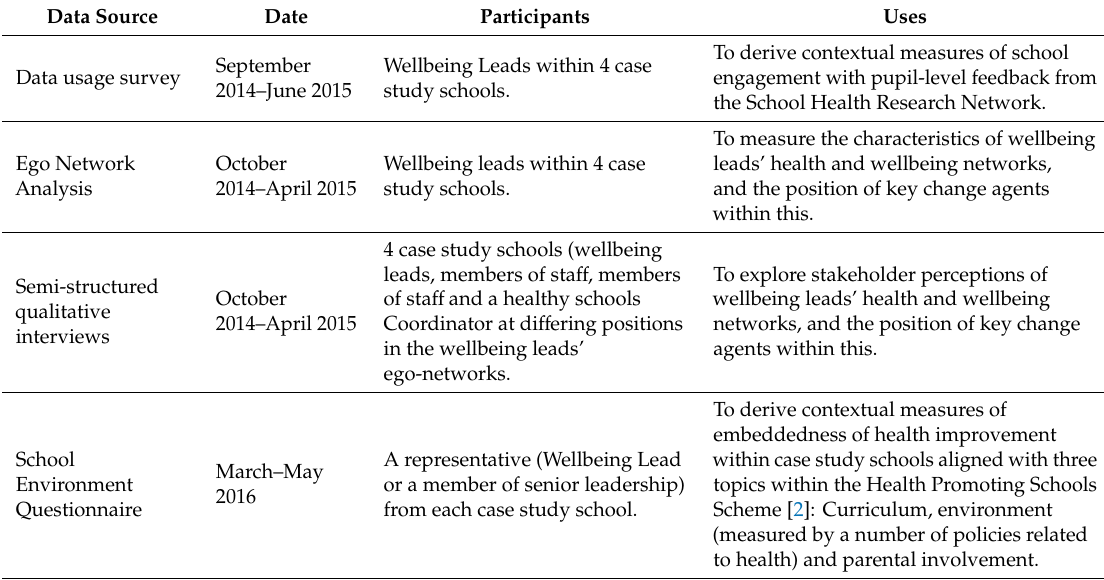
Table 1. Study data